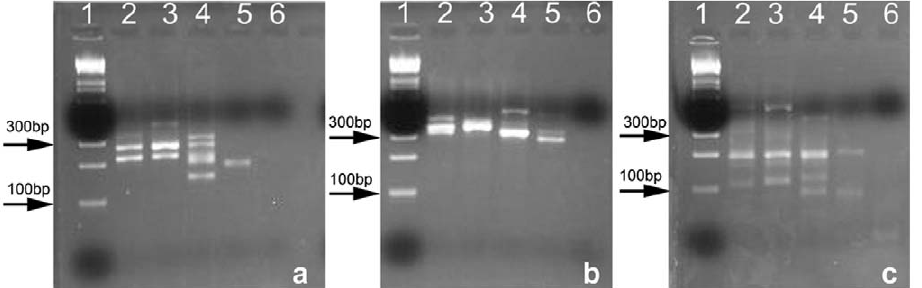
Figure 4. Agarose gel electrophoresis images from a) Algal ITS1 ( , 100–300 bp), b) Algal ITS2 ( , 300 bp) and c) Archaeal 16s ( , 200 bp). Sample order: Lane 1: DNA ladder, 2: Modern Saline Valley, 3: Saline Valley , 36 ka, 4: Saline Valley , 64 ka, 5: Saline Valley , 150 ka, and 6: PCR –ve.